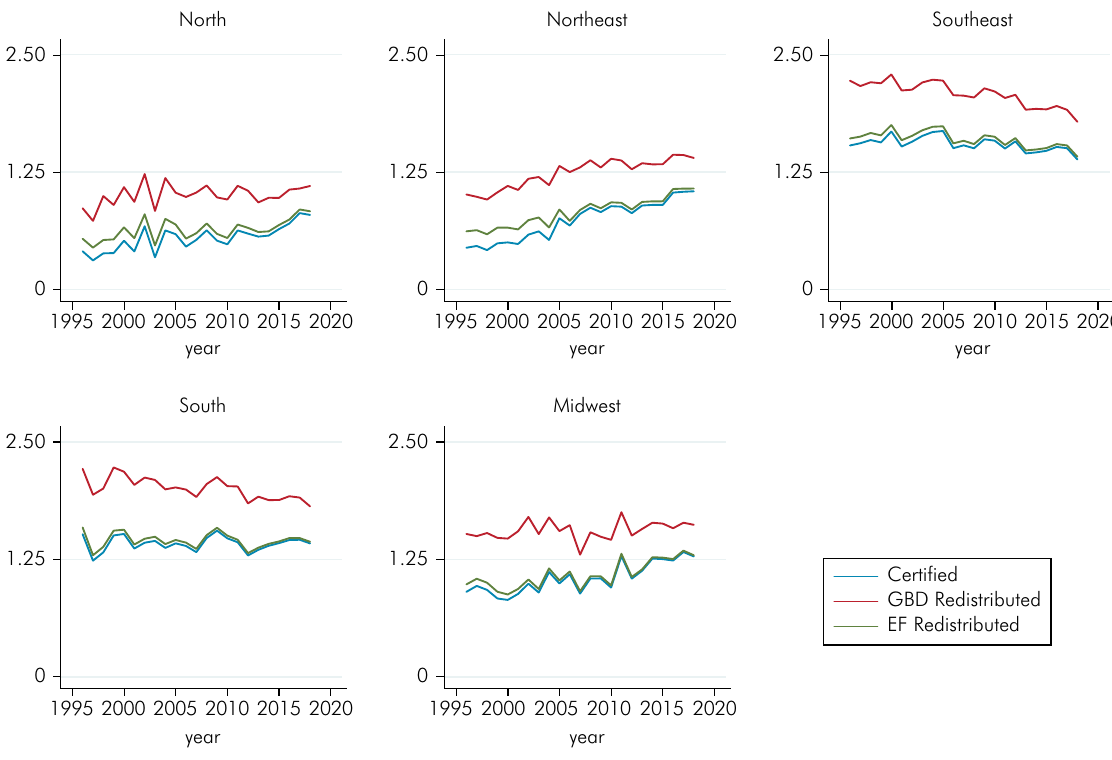
Figure 2. Oropharyngeal cancer mortality, Brazil, 1996-2018. Certified and redistributed death rates by macro-region, both sexes, per 100,000 inhabitants.